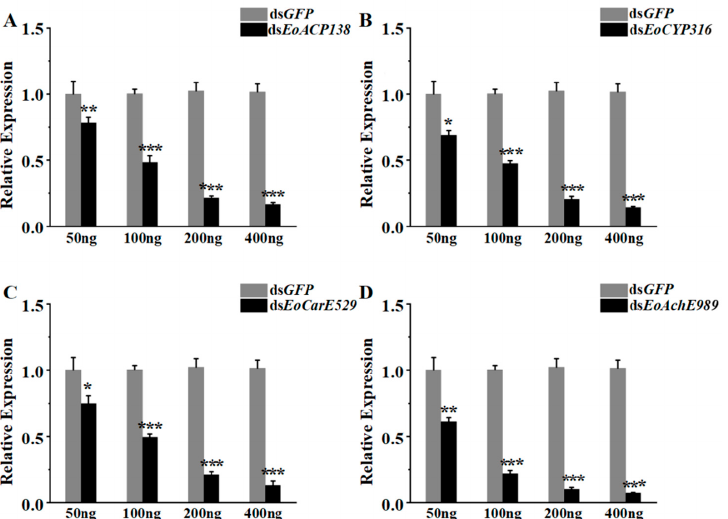
Figure 4. RNAi efficiency analysis of genes related to detoxification from E. oblique after injection of dsRNA. ( A ) The expression analysis of EoACP138 at 24 h after injection of dsEoACP138 by qRT-PCR. ( B ) The expression analysis of EoCYP316 at 24 h after injection of dsEoCYP316 by qRT-PCR. ( C ) The expression analysis of EoCarE592 at 24 h after injection of dsEoCarE592 by qRT-PCR. ( D ) The expression analysis of EoAchE989 at 24 h after injection of dsEoAchE989 by qRT-PCR. Each bar represents the mean ± SD. Asterisks indicate significant differences in expression level between GFP and four different genes after RNAi. * = p < 0.05, ** = p < 0.01, and *** = p < 0.001.